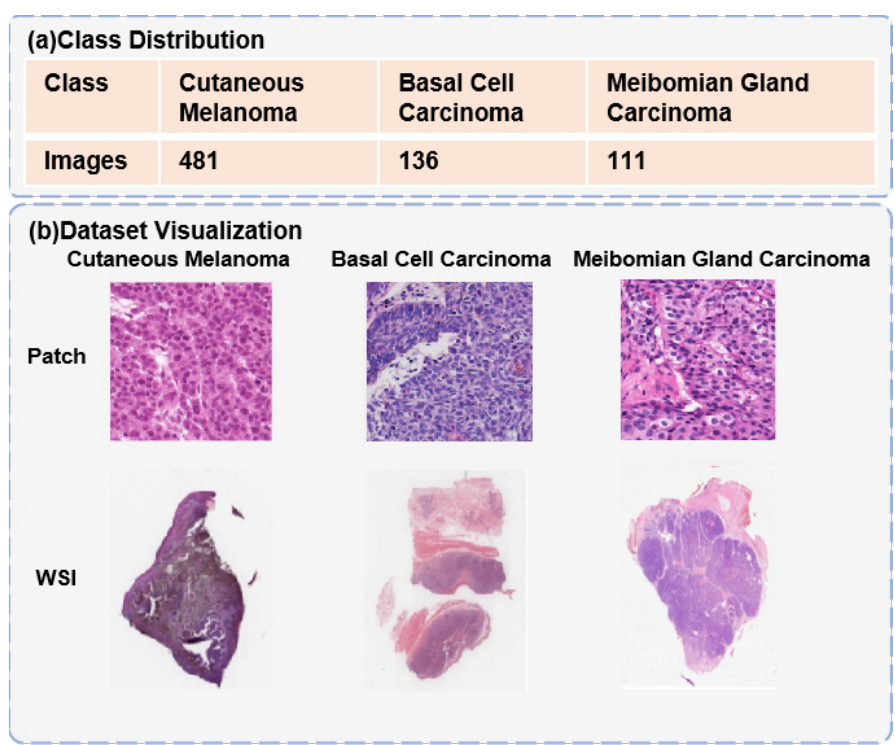
Figure 4. Details of Dataset: ( a ) denotes the class distribution and the number of images in the ZLet dataset, and ( b ) represents the data visualization of each type of eyelid